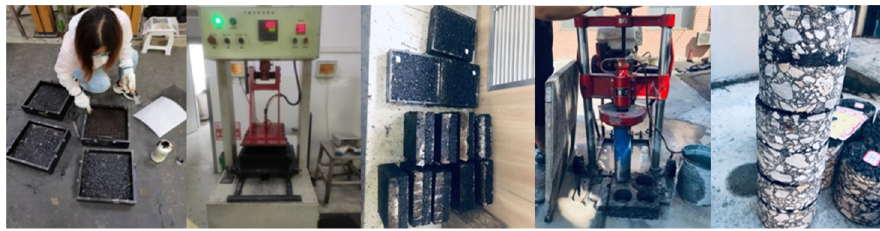
Figure 2. The preparation of test specimens.